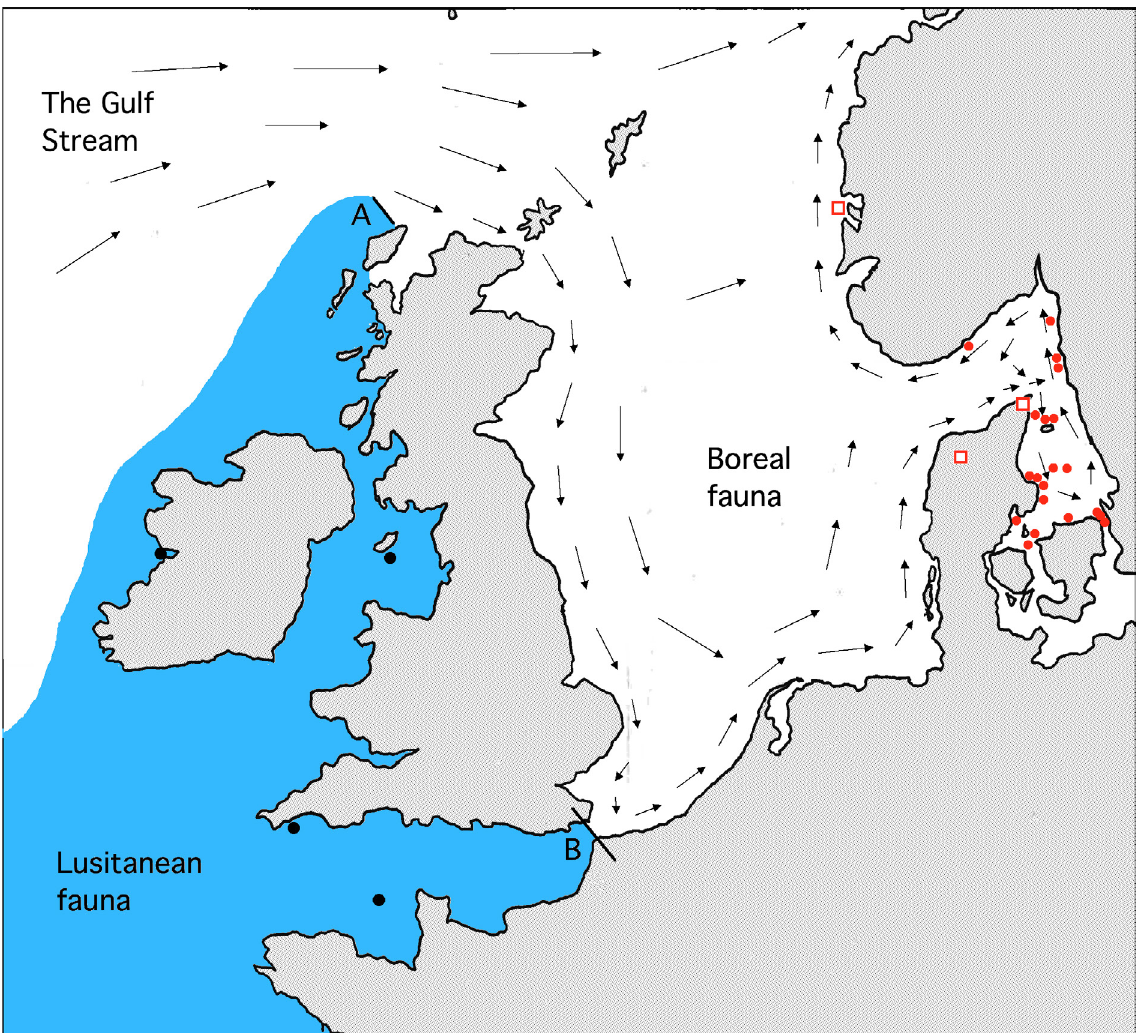
Fig. 3. Map of the sea around NE Europe. Compiled on the basis of Ekman (1953), Dietrich (1963), Wikander (1981), Hylleberg & Riis-Verstergaard (1984), Petersen (1991, 2004) and Lund-Hansen et al . (1994). Red dots indicate finds of Modiolus cimbricus sp. nov., and red squares indicate empty shells or subfossils only. Black dots indicate Modiolus adriaticus (Lamarck, 1819) in our material. The lines A and B indicate approximately the northern limits of the fauna influenced by Lusitanian (Mediterranean) species (blue colour). See the section Distribution for further